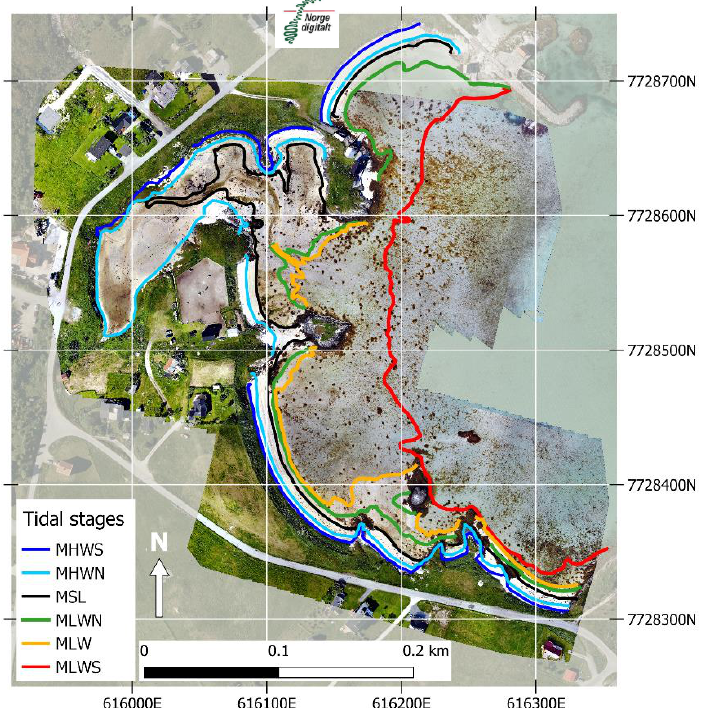
Figure 10. Aerial image mosaic taken with a DJI Mavic Air quadcopter over Avløsbukta at Hillesøy